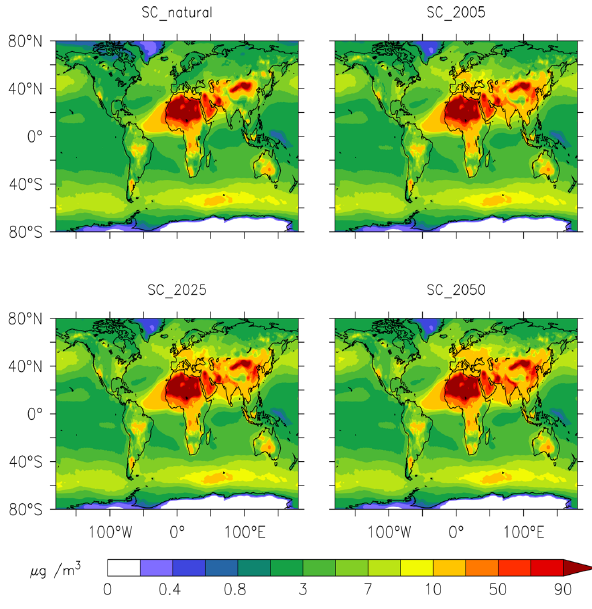
Fig. 8. Model calculated annual mean near-surface PM 2 . 5 in µg m − 3 from simulation SC natural , SC 2005 , SC 2025 and SC 2050